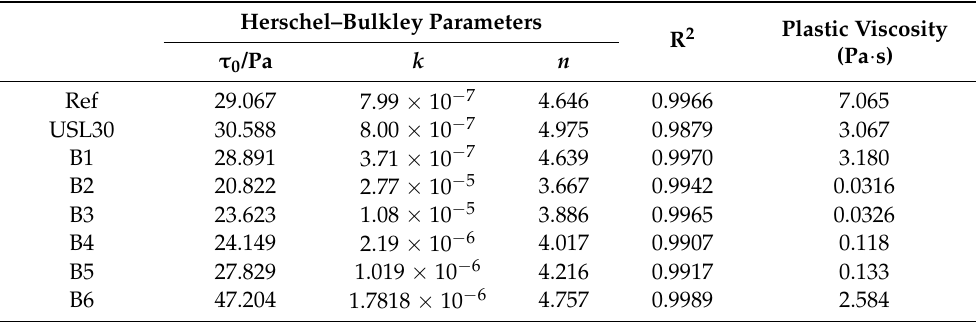
Table 3. Herschel–Bulkley parameters and of the plastic viscosity paste with different LS and USL dosages.